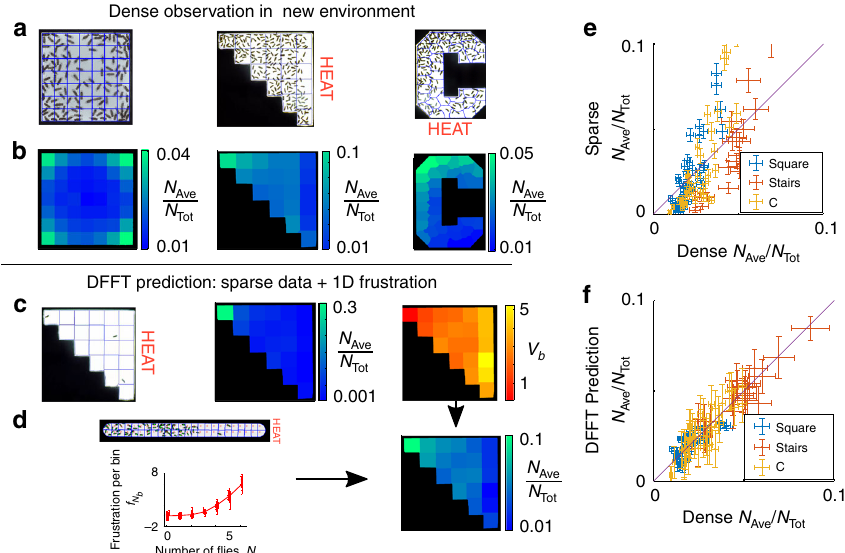
Fig. 3 Predictions of large crowd distributions in three new environments. a Experimental observations of dense crowds (124, 219, and 189 fl ies) in three chambers with different geometries, two with applications of heat creating temperature differences of up to 20 °C. b Measured single- fl y probability distributions, N Ave / N Tot . c , d DFFT protocol applied to the stair-case geometry. c Measurement of the density for 3 fl ies is used to determine the vexation, v b . d Combining this vexation with the extracted quasi 1D frustration from Fig. 2 leads to the high density DFFT prediction. e Comparison of single- fl y probabilities for the sparse and dense populations shows signi fi cant population shifts as indicated by a correlation coef fi cient r = 0.73 and a σ mean = 3.8. f DFFT analysis that incorporates interactions predicts the measured dense population distribution within statistical uncertainty ( r = 0.96 with a σ mean = 1.0). Vertical error bars correspond to s.d. of bin-occupation distributions and horizontal error bars correspond to s.e.m. of the observed density within a given